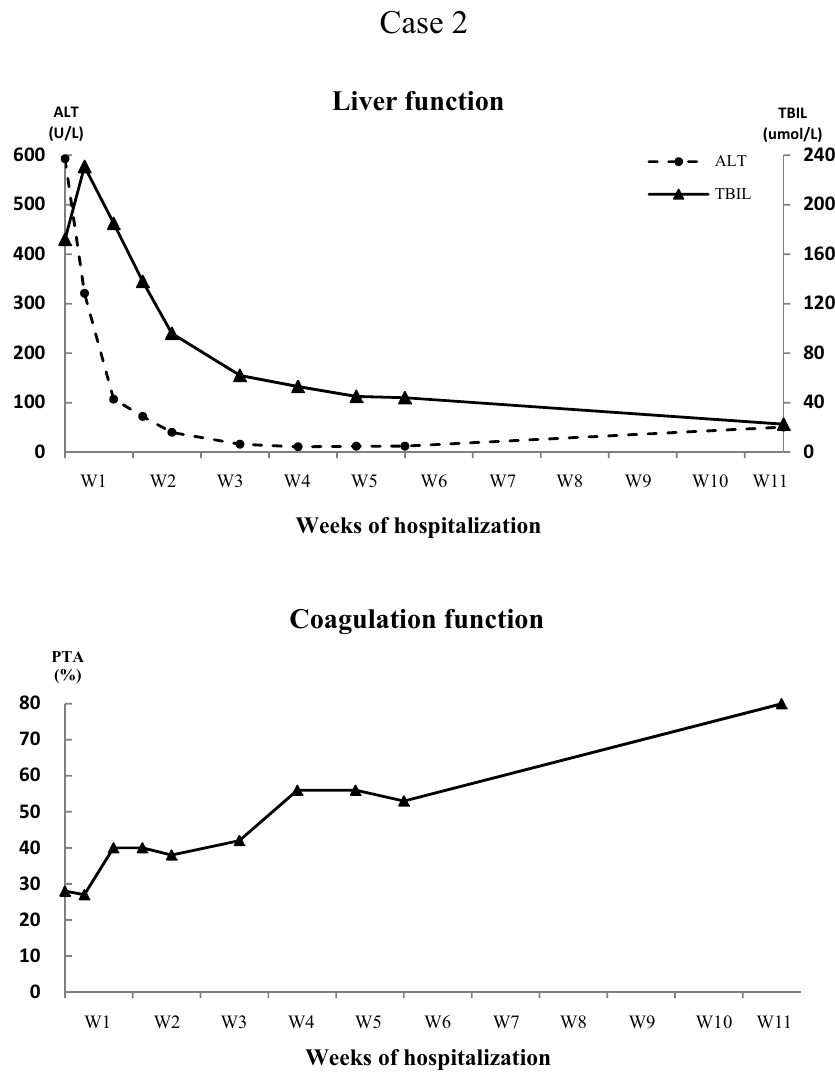
Figure A2: The level of ALT, TBIl and PTA of case 2 during hospitalization.